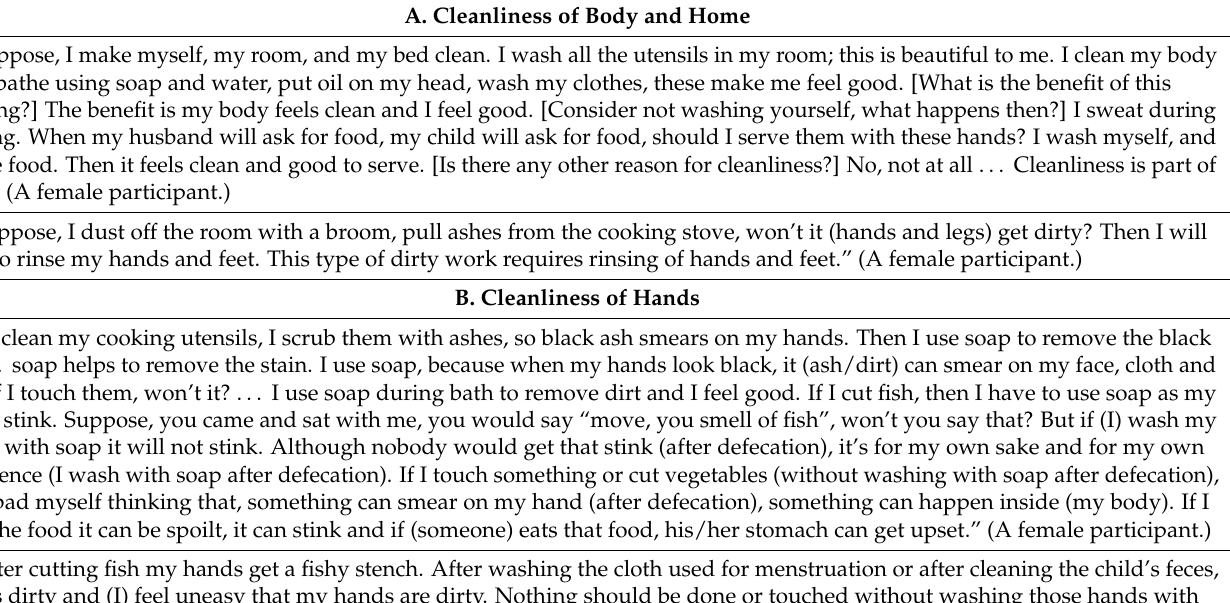
Table 2. Quotations regarding cleanliness from the study participants in Arichpur, Dhaka, from May 2015 to March